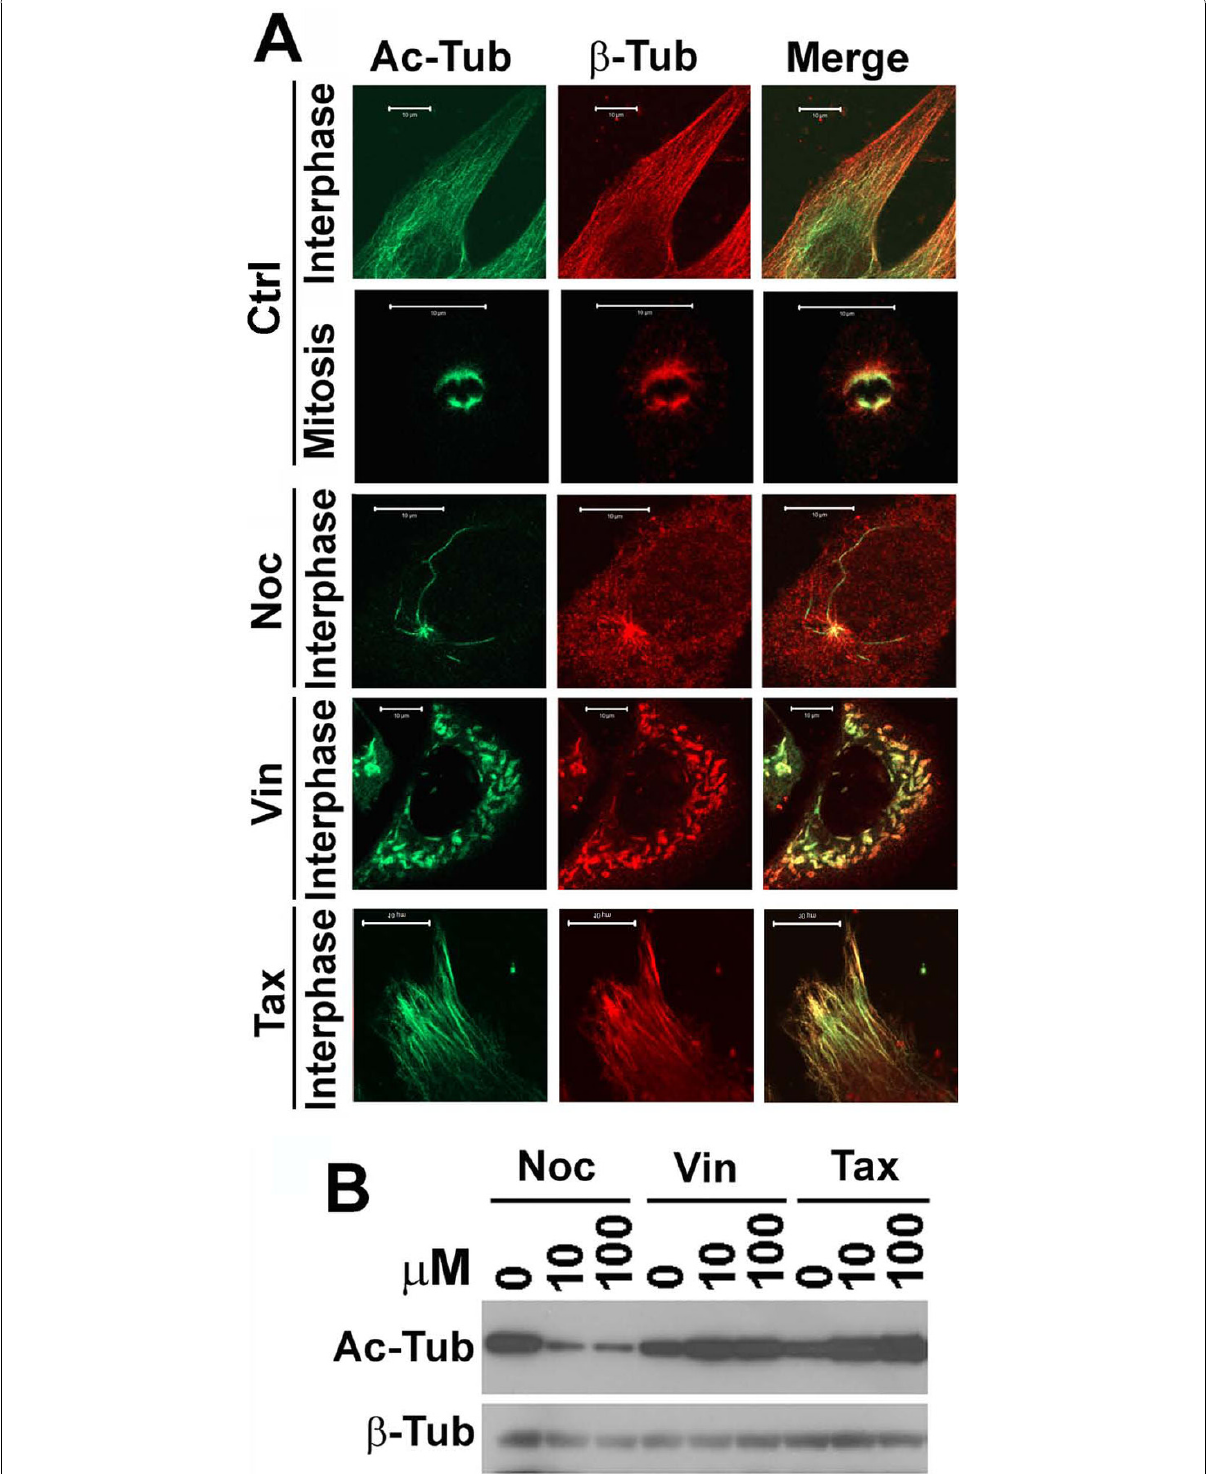
Figure 3 Impact of paclitaxel, vinblastine and nocodazole on microtubular acetylation and structure . ( A ) Immunostaining of microtubules in HeLa cells untreated or treated with 10 μ M of nocodazole, vinblastine or paclitaxel overnight with antibodies against acetylated a -tubulin and normal b -tubulin. Ac-Tub, acetylated a -tubulin. b -Tub, b -Tubulin. Vin, vinblastine. ( B ) Immunoblotting analysis of acetylated a -tubulin levels in lysates of HeLa cells treated with different concentrations of nocodazole, vinblastine and paclitaxel for